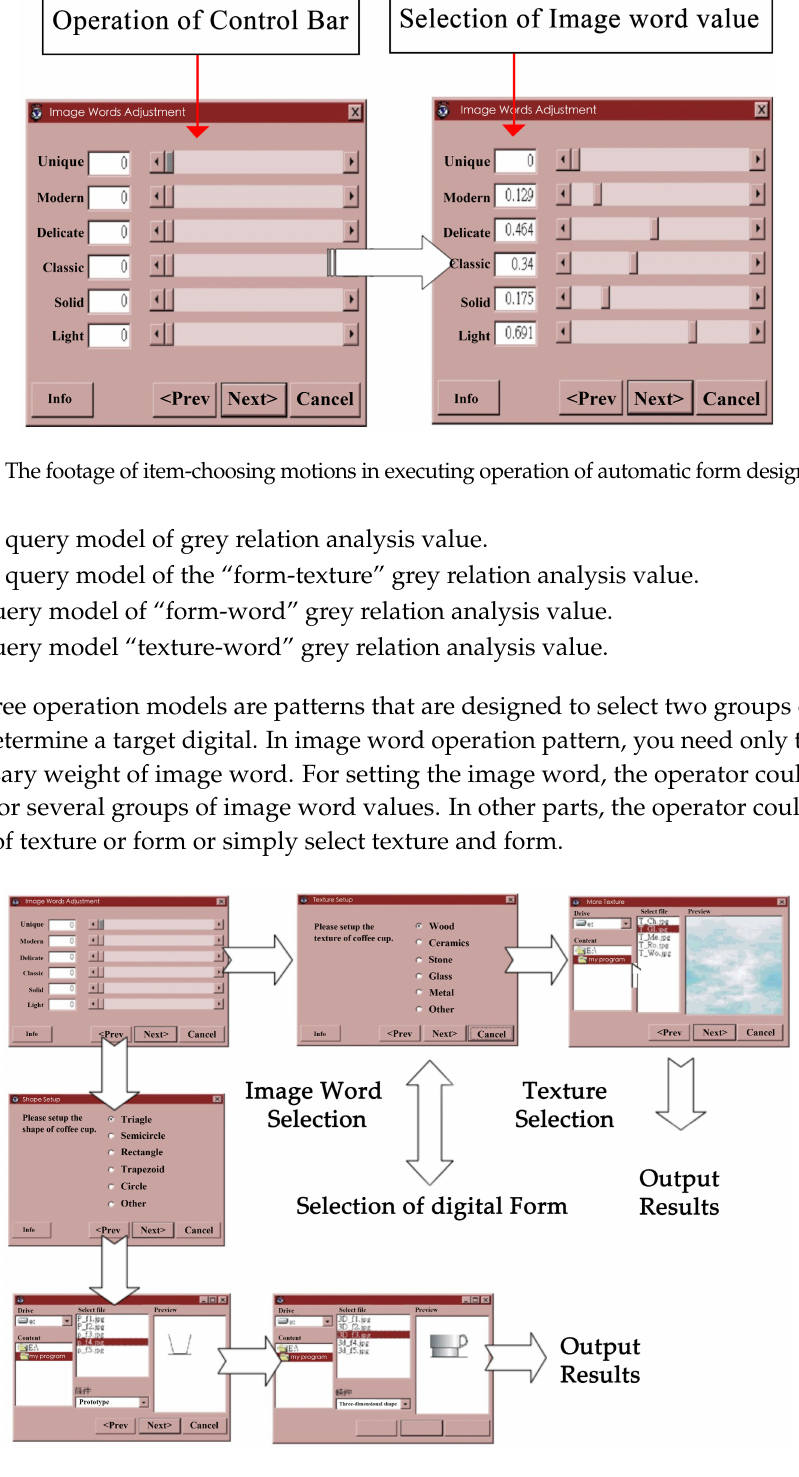
Figure 13. The operation of program interface of automatic form design